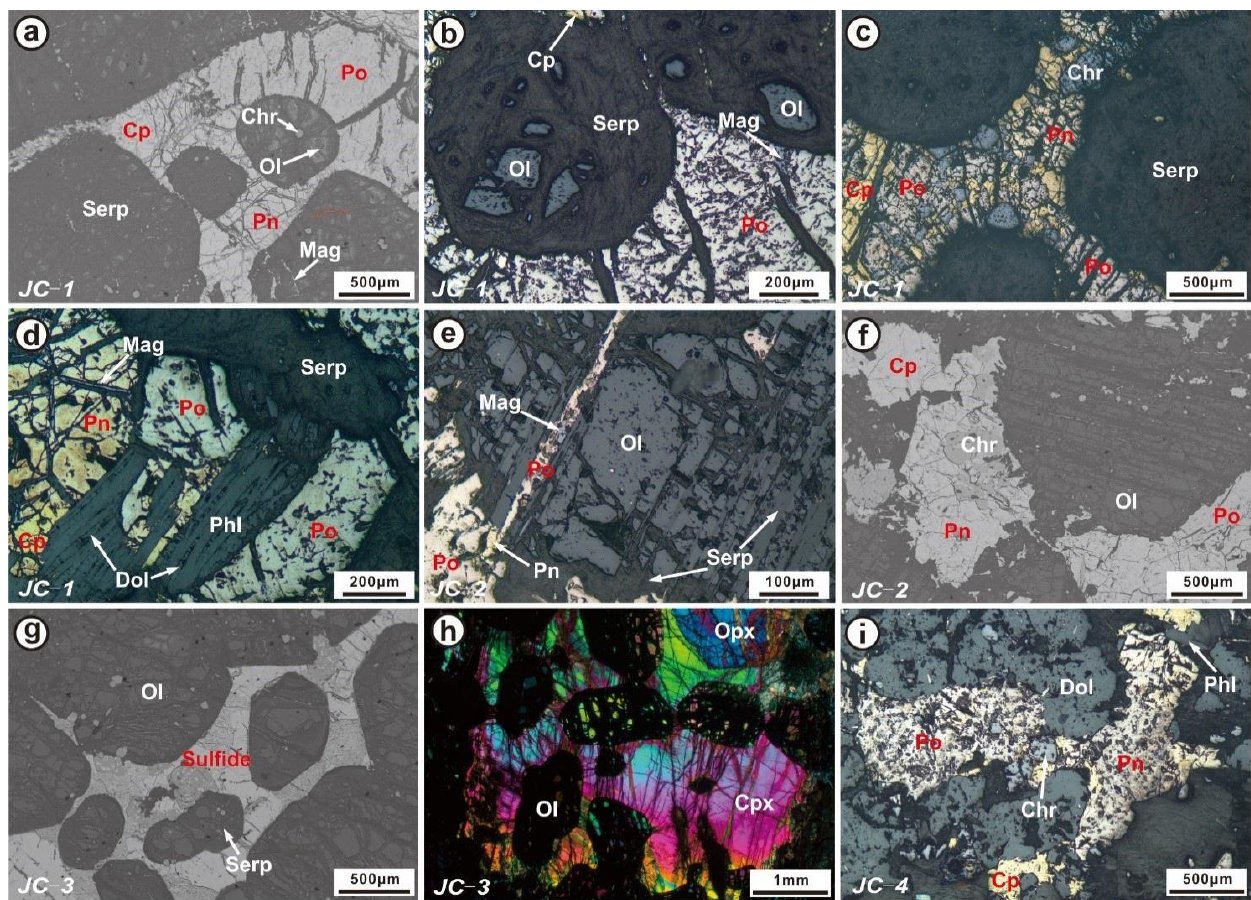
Figure 4. Photomicrographs and backscattered electron images of coexisting minerals from net-textured ores (JC-1 ( a – d ), JC-2 ( e , f ), and JC-3 ( g , h )) and disseminated ore (JC-4 ( i )) under transmitted light ( h ), reflected light ( b – e , i ). Panels of a and f-g are backscattered electron images. ( a ) Sample JC-1 is a net-textured sulfide-rich dunite, where olivine is almost entirely serpentinized with tiny olivine relicts preserved for analysis (Fo = 82–84%) and minute secondary magnetite traces along cracks. The sulfides are mostly pyrrhotite, pentlandite, and chalcopyrite. ( b ) Serpentines take the pseudomorphs after euhedral olivine with minute relicts. Pyrrhotite accounts for half of all the sulfide minerals. ( c ) Similar to ( a ) and ( b ), but there are chromite granules coexisting with sulfide minerals as indicated. ( d ) Minor secondary magnetite of serpentinization origin along cracks and grain boundaries of sulfide minerals. There are also grains of dolomite and phlogopite formed by the late alteration. ( e ) Sample JC-2 is a net-textured sulfide-rich dunite with serpentinization occurring along the olivine cracks. ( f ) Sulfide minerals are connected to form a network between serpentinized olivine grains. ( g ) Sample JC-3 is a net-textured sulfide-rich lherzolite with minor serpentinization. ( h ) Fresh portion of JC-3, showing cumulate of olivine, orthopyroxene, and minor clinopyroxene. The clinopyroxene is anhedral as interstitial fills between olivine and orthopyroxene. ( i ) Sample JC-4 is a disseminated sulfide-rich altered ore from metasomatic orebody, containing altered dolomite, phlogopite, and amphibole with minor serpentine. Mineral abbreviations: Ol = olivine; Srp = serpentine; Cpx = clinopyroxene; Opx = orthopyroxene; Chr = chromite; Mag = magnetite; Po = pyrrhotite; Cp = chalcopyrite; Pn = pentlandite; Dol = dolomite; Phl =